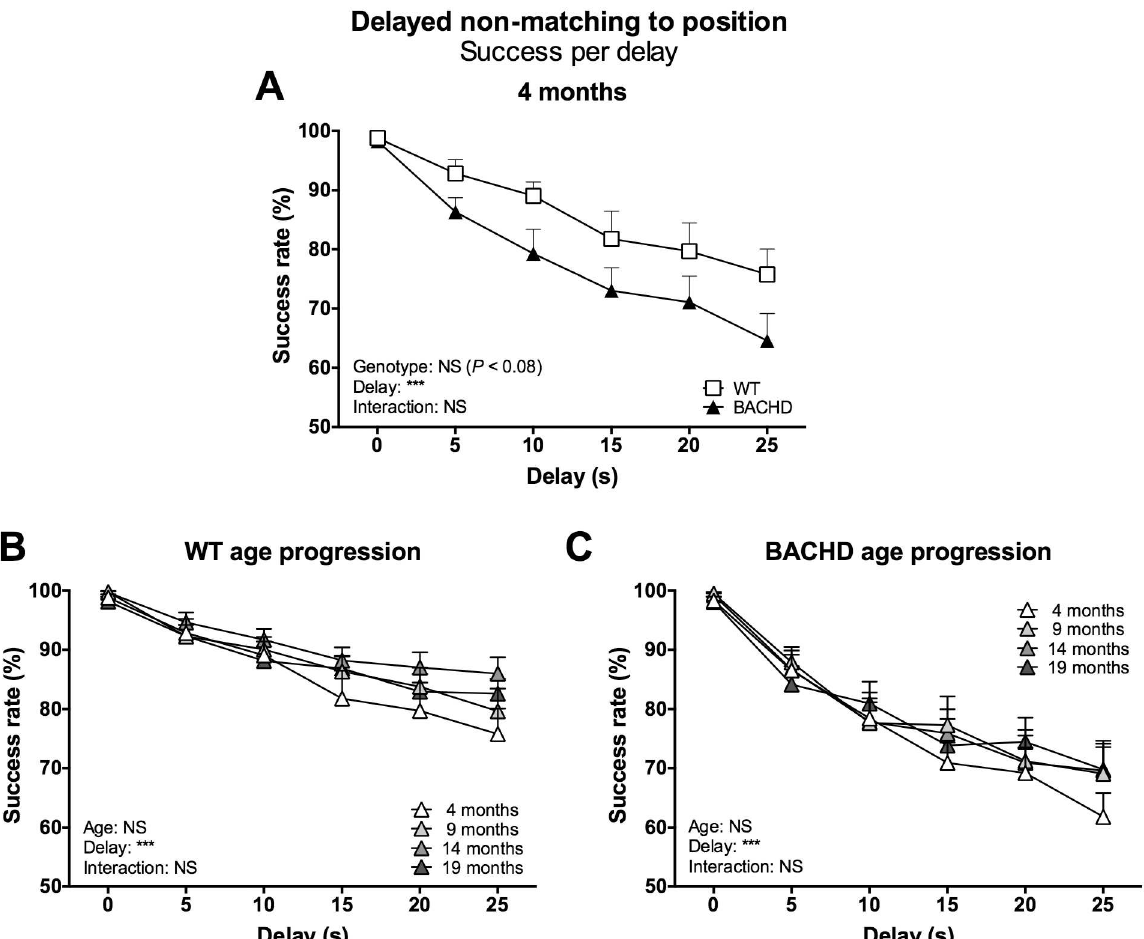
Fig 7. Success rate per delay in the delayed non-matching to position test. The graphs show the success rate on trials with delays of different durations in the delayed non-matching test. (A) shows the stable baseline performance of rats maintainedon the standard food restriction protocol at four months of age. (B) and (C) show the age progression of performance for WT and BACHD rats, respectively. Curves display group mean plus standard error. Results from two-way repeatedmeasures ANOVA are shown inside the graphs. For (A), results from post-hoc analysis are indicated in case significant genotype differences were found. * ( P < 0.05) ** ( P < 0.01) *** ( P <